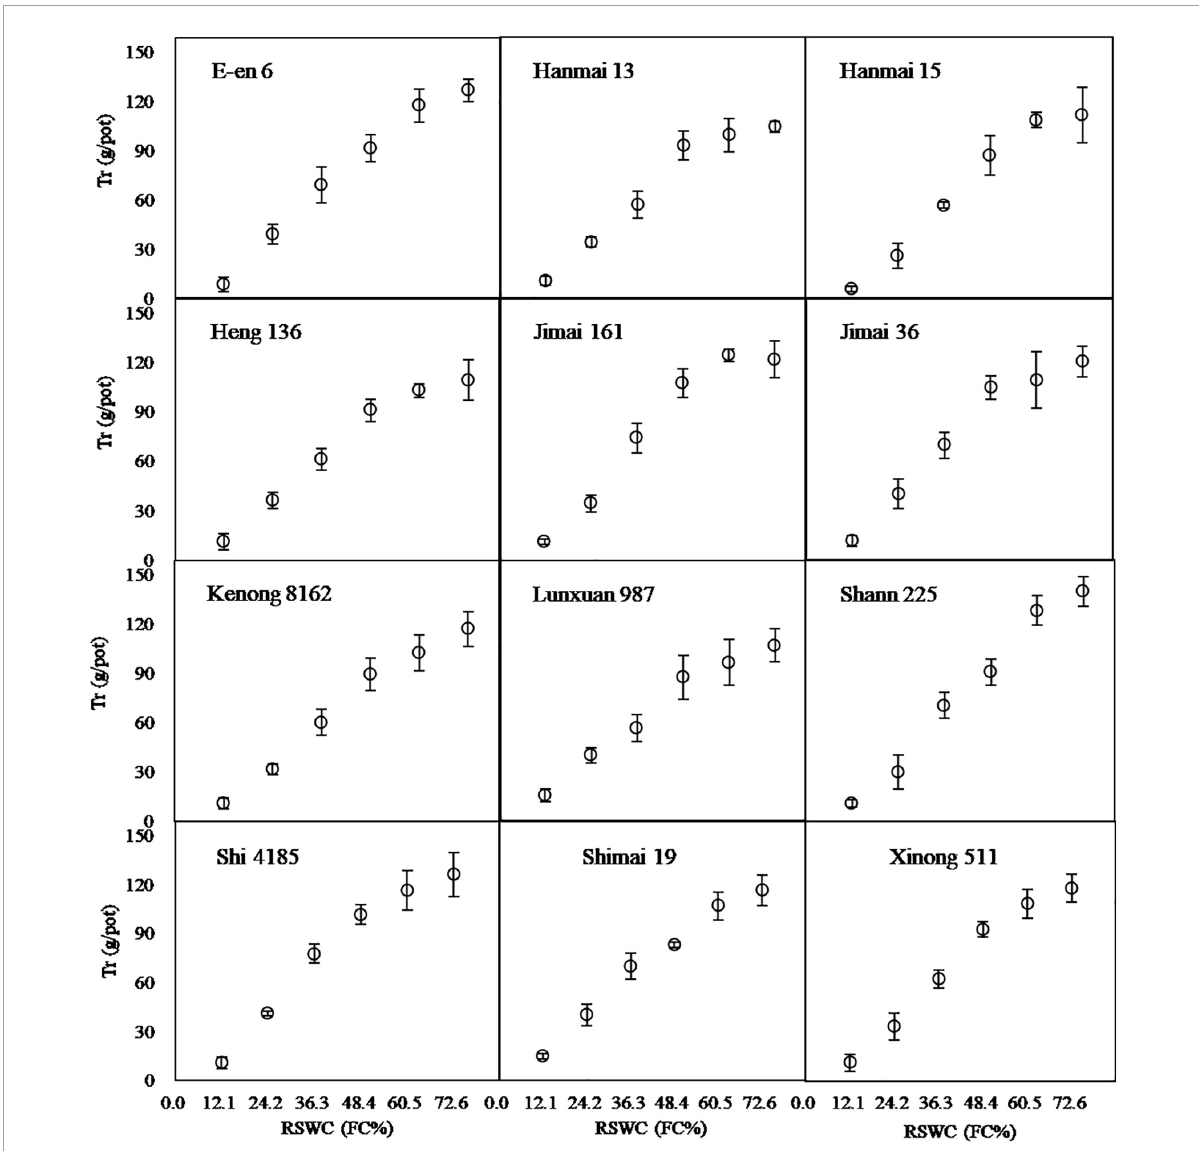
FIGURE4 Transpiration per pot after 33 days cultivation under 6 soil water contents. RSWC , soil water content. FC , field capacity. Data are shown as Mean ± SD, n =